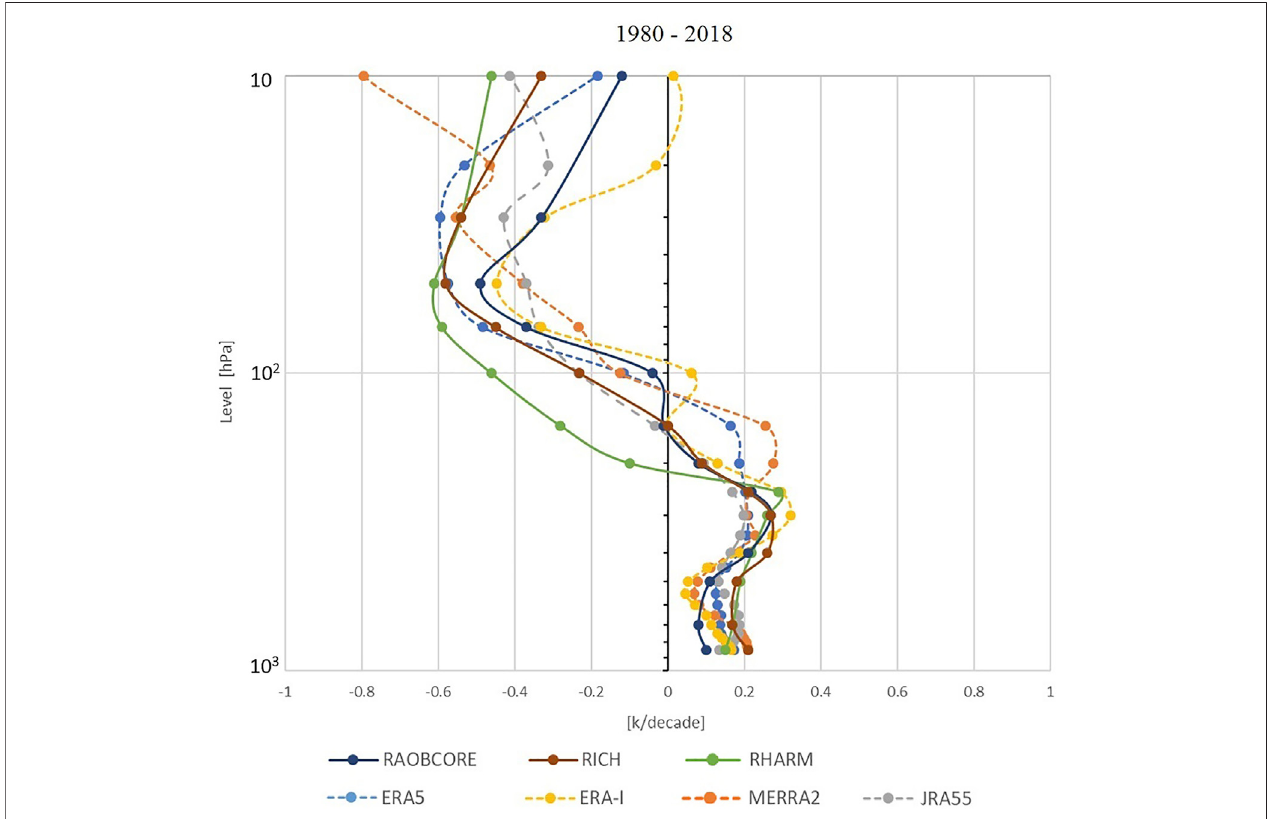
FIGURE 9 | Vertical pro fi les of temperature trends (K/decade) for tropics (25 ° N - 25 ° S) of radiosonde observations (solid lines) and the four considered reanalysis datasets (dashed lines), spanning the period 1980 – 2018.